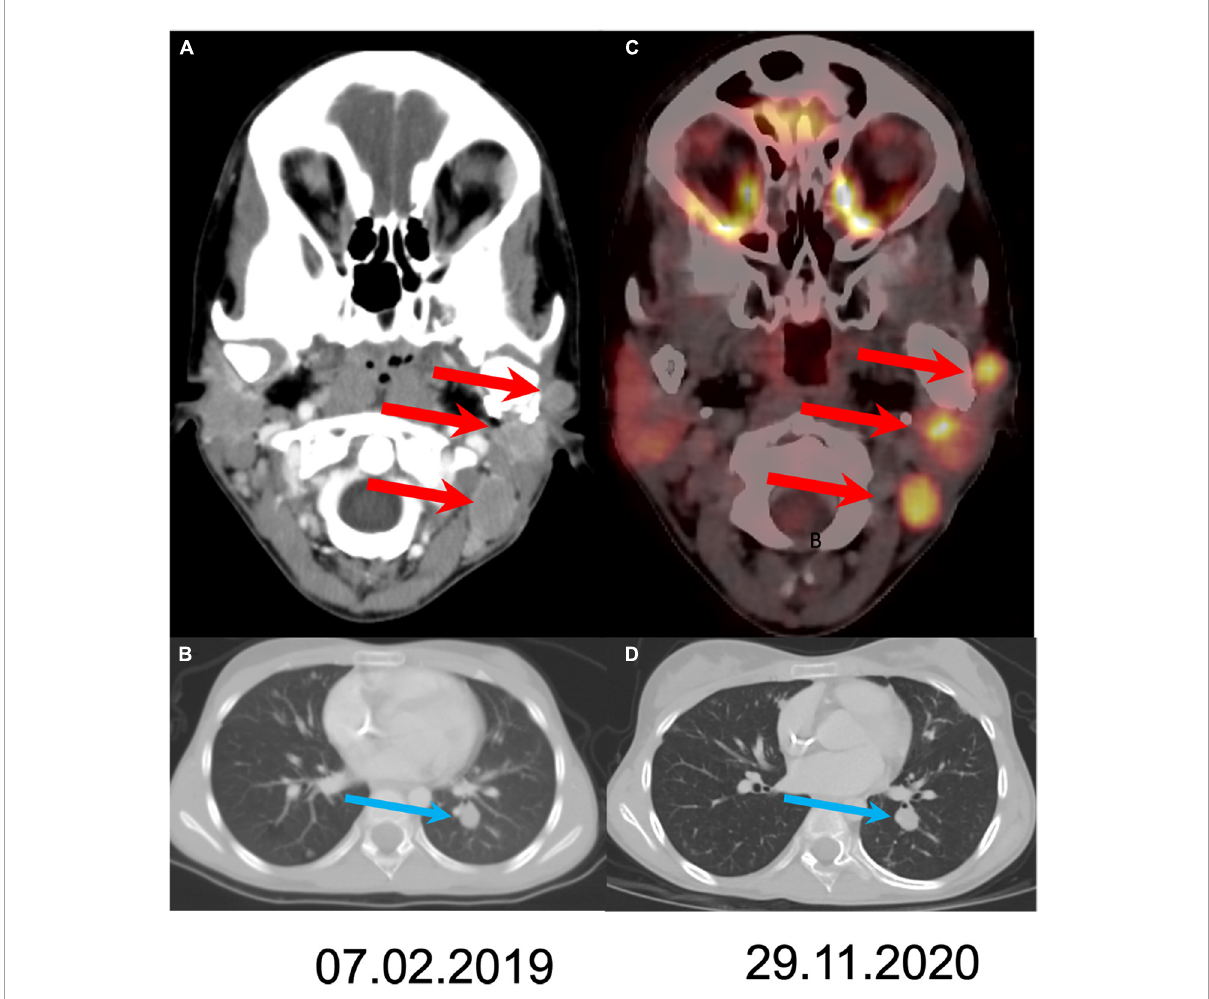
FIGURE2 Comparison of disease extent at the initiation of treatment and after 21 months of follow-up. Axial CT slides at staging (A,B) show three metastases (arrows) in the left neck and lung spread. Follow up after 21 months shows stable disease both in the neck ( C ; fused PET/CT axial slide) and in the lung (D)